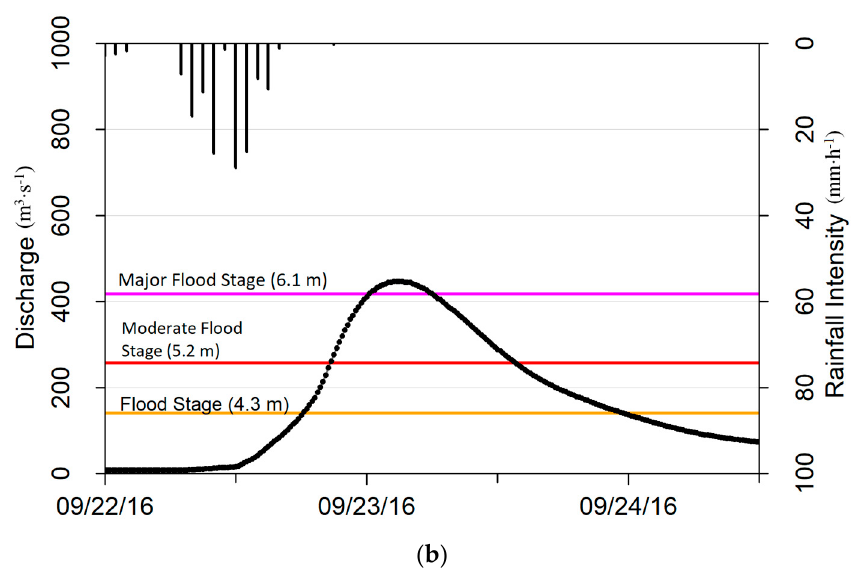
Figure 2. ( a ) The observed discharge in units of m 3 ⋅ s − 1 (black dots) at the USGS streamflow gauge on the Maquoketa River at Manchester during the July 2010 flood, with hourly Stage IV radar rainfall intensity time series in mm ⋅ h − 1 (black vertical bars) and the three NWS flood stage categories (horizontal colored lines) ( b ) the September 2016 flood.